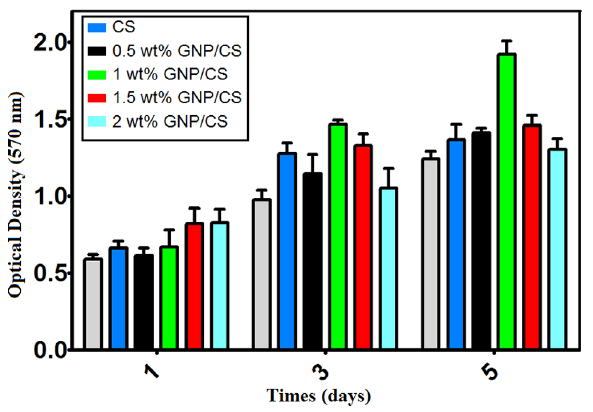
Figure 13. Proliferation of hFOB osteoblasts on different GNP/ CS composites in comparison with pure CS and blank assessed using MTT assay ( p , 0.05, n =5).